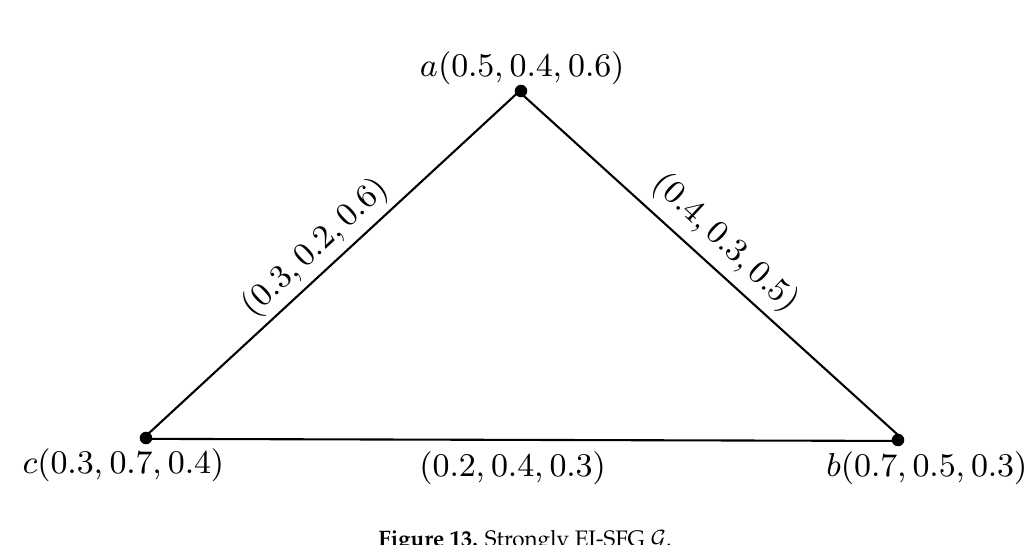
Figure 13. Strongly EI-SFG G Figure 13: strongly EI-SFG G